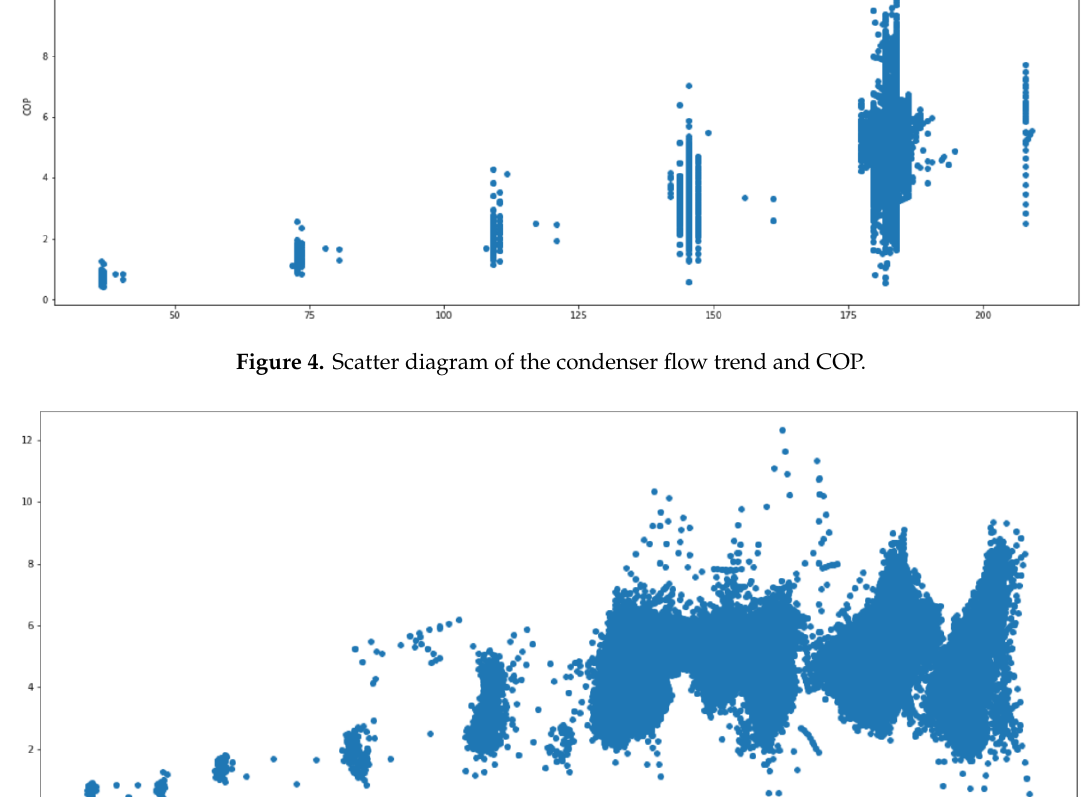
Figure 5. Scatter diagram of the chilled water flow and COP.